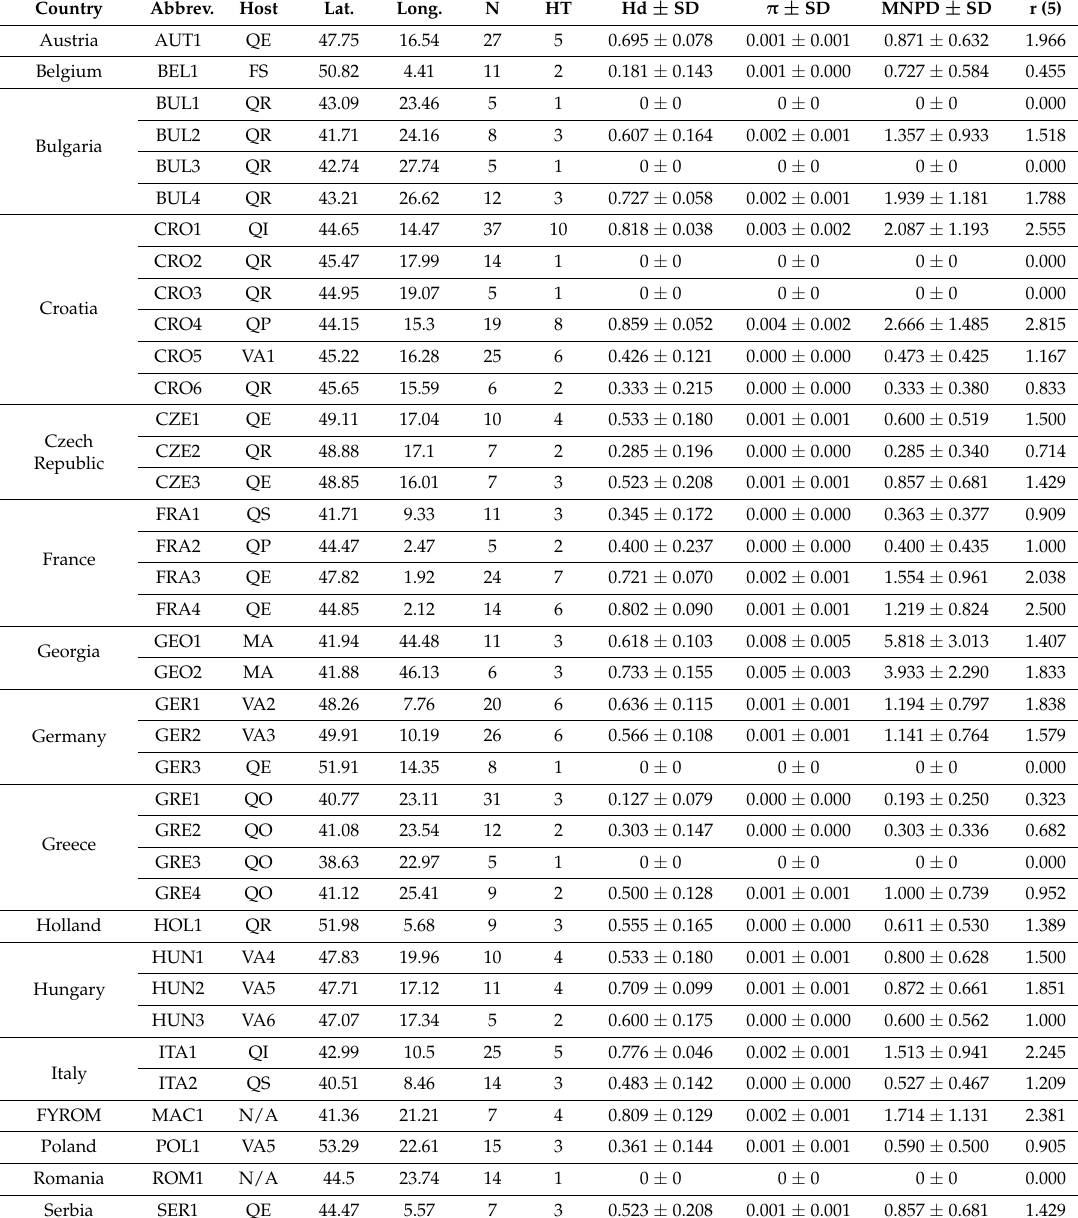
Countries, localities, WGS84 coordinates in degrees (Lat., Long.), host tree (QE = Quercus petraea ; QR = Q. robur ; QI = Q. ilex ; QP = Q. pubescens ; QS = Q. suber ; QO = Q. coccifera ; FS = Fagus sylvatica ; MA = Malus sp.; VAR1 = Q.petraea + F.sylvatica ; VAR2 = Q. robur + F. sylvatica ; VAR3 = Q. robur + Q. petraea ; VAR4 = Q. petraea + Q. pubescens ; VAR5 = Salix sp. + Populus sp.; VAR6 = Q. rubra + Q. petraea + Q. cerris + Carpinus betulus + Fraxinus sp.), number of individuals (N), number of haplotypes (HT), haplotype diversity (Hd), nucleotide diversity ( π ), mean number of pairwise differences (MNPD), and Allelic richness (r) after rarefaction to smallest sample size (5). Mean value and standard deviation (SD) is shown for all genetic diversity indices except for